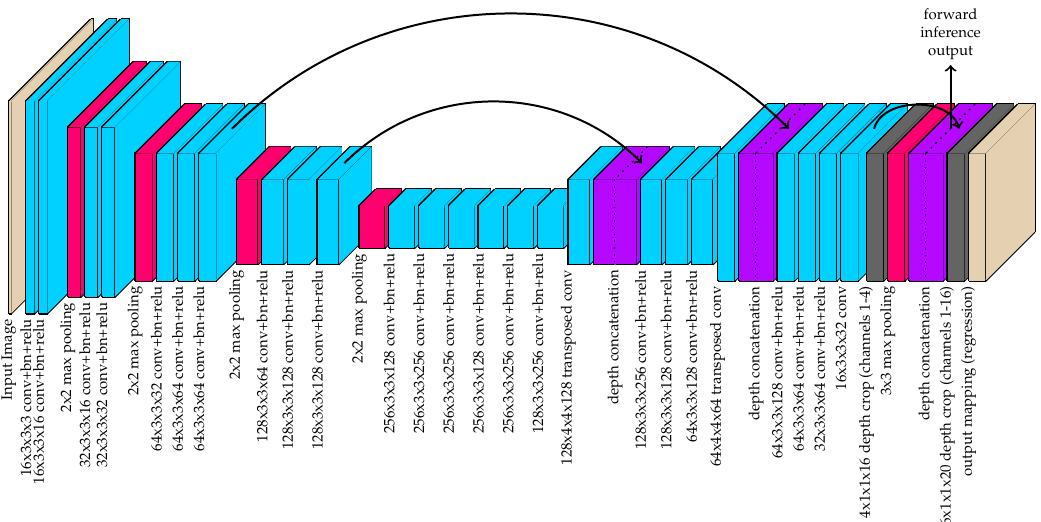
Figure 3. The hourglass-shaped network used by the proposed method to convert images to 16-channel image-space instance detection maps. The black arrows indicate a copy for depth concatenation. The gray depth crop layers indicate untrainable convolutional layers that isolates certain channels of the input. While the final output layer is used for training with MSE regression, the output of the 3rd depth concatenation is used for forward inference. By including the 3 × 3 max pooling output of the channels 1–4 along with their original outputs, this allows for fast peak detection in